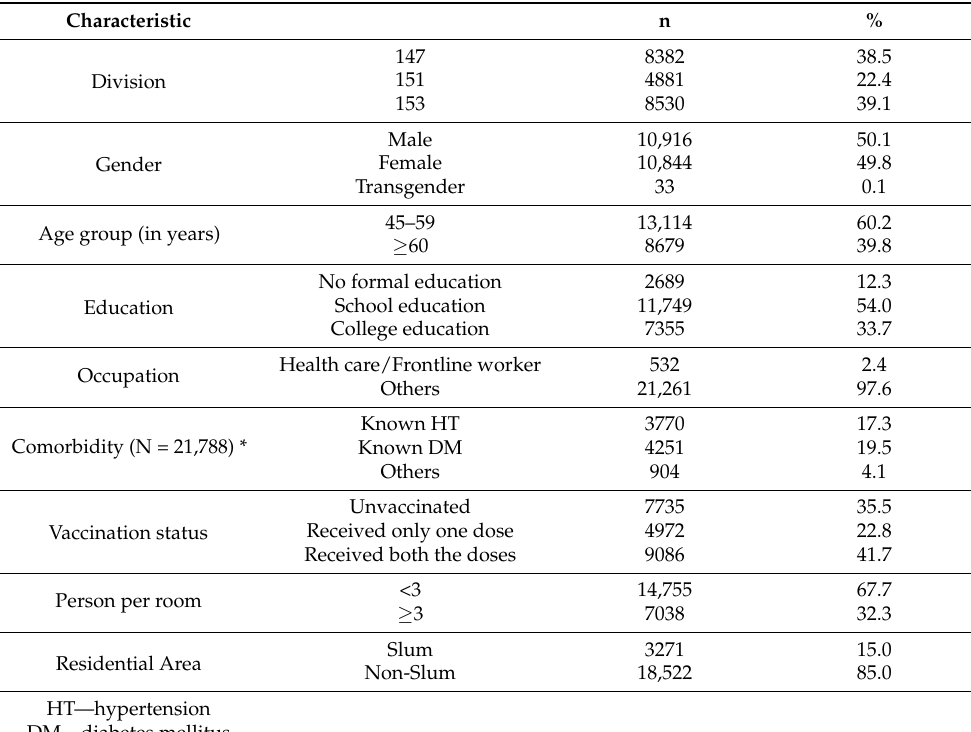
Table 1. Socio-demographic characteristics of the individuals ≥ 45 years included in the analysis of the COVID-19 vaccine effectiveness cohort study, Chennai, 2021 (N = 21,793).